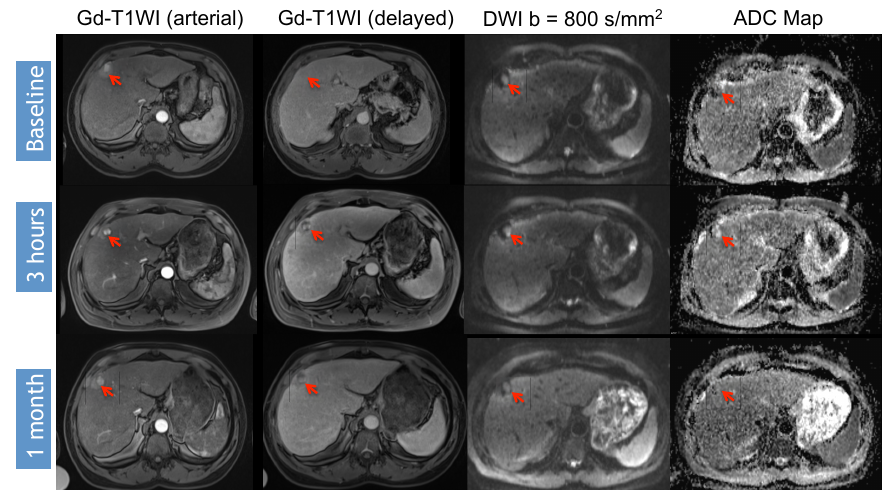
Figure 2. DWI Response Assessment after DEB-TACE treatment. 69-year-old man presented with a segment V HCC (arrow) without macrovascular invasion or extrahepatic disease. Note that there is decreased peripheral enhancement at 3 h that becomes more evident at one month. When analyzing DWI images, ADC values increased ≥20% in the treated region (baseline ADC 0.704 × 10 −3 mm 2 /s, post-3 h ADC 1.30 × 10 −3 mm 2 /s); however, a small nodule of restricted diffusion persists at one month (ADC 0.940 × 10 −3 mm 2 /s). The findings represent a subjective and objective measurement of response, in this case representing partial response (PR) to therapy.